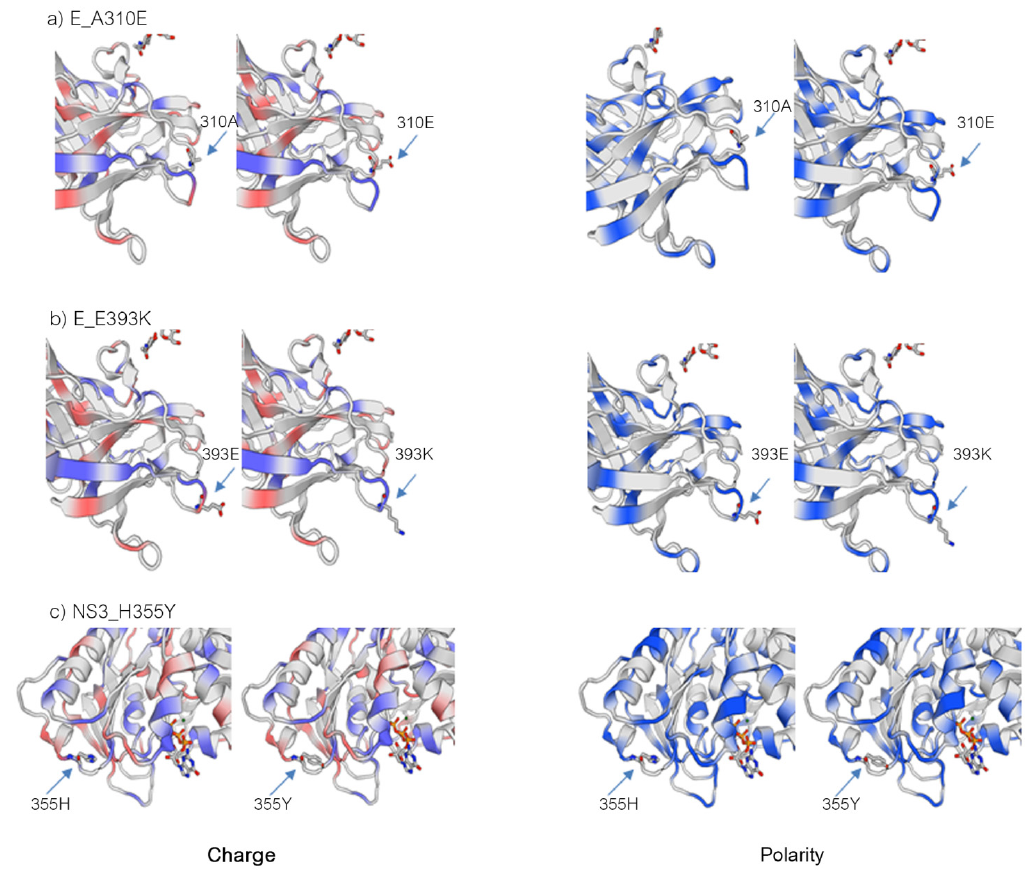
Figure 4. Effects of mutations on polarity and charge of protein in the mutation region. SWISS- MODEL was used to model and visualize the changes in charge (left) and polarity (right) in the mutation residues of E:DIII and NS3:DII, using PBD: 5LBV and PBD: 5GJB, respectively. The A310E mutation on E:DIII ( a ) shows a change from an uncharged, nonpolar residue to a negatively charged, polar residue, while the E393K mutation ( b ) goes from a negatively charged, polar residue to a positively charged polar residue. The H355Y mutation on NS3 ( c ) shows a change from a positively charged, polar residue at pH 7.2 to an uncharged, polar